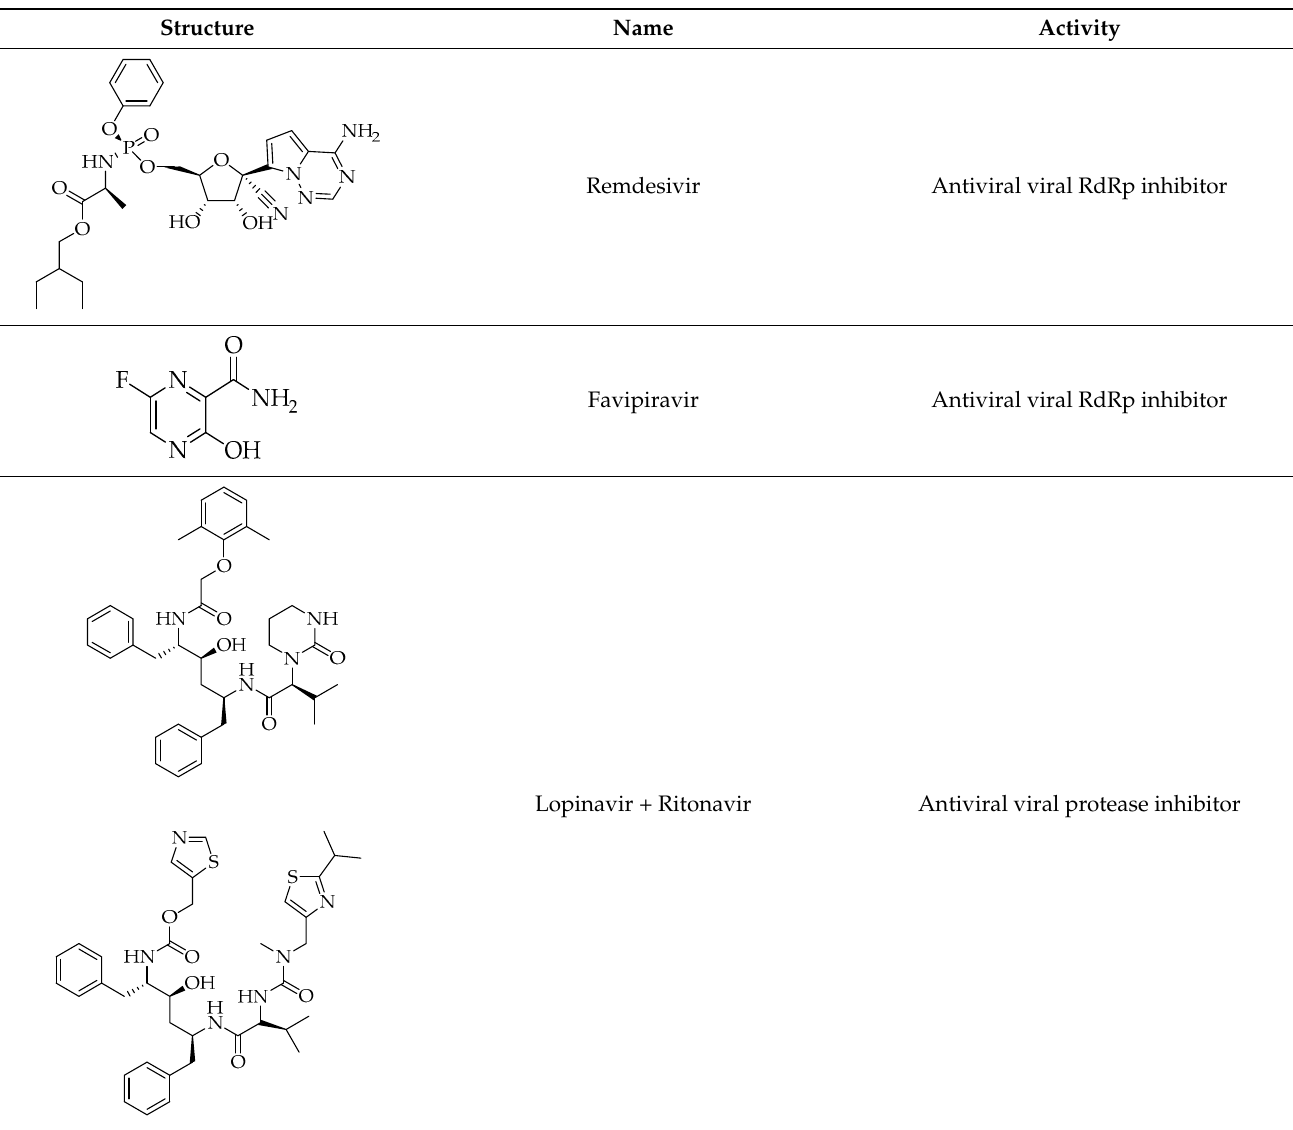
Table 1. Drugs used to treat COVID-19.